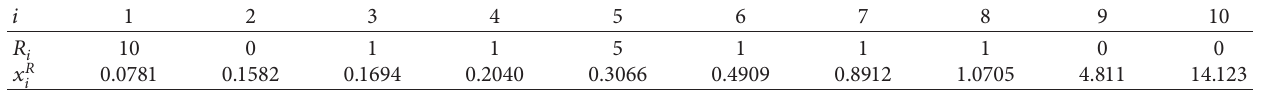
Table 1: Simulated Pro-F-F-C.